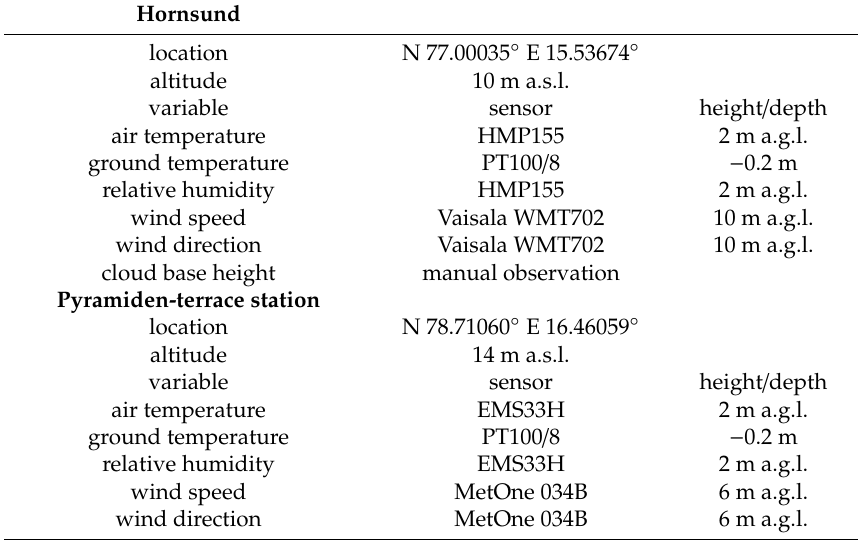
Table 2. Meteorological parameters measured in Hornsund and Pyramiden sampling